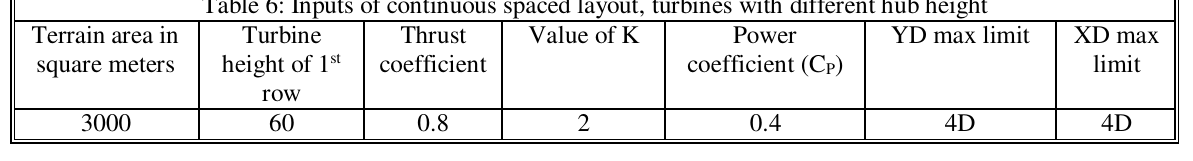
Table 6: Inputs of continuous spaced layout, turbines with different hub height